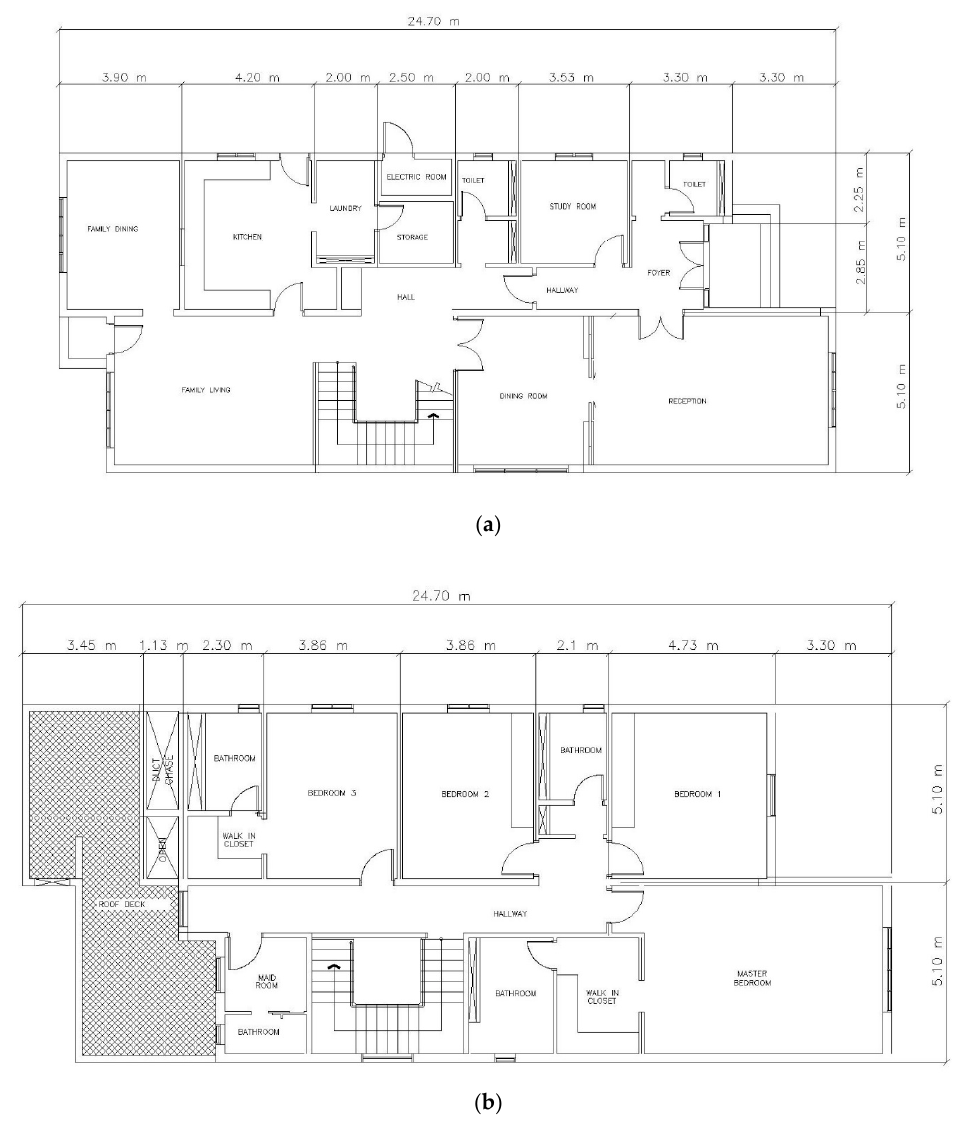
Figure 3. Building floor plans. ( a ) Ground floor; ( b ) First floor.